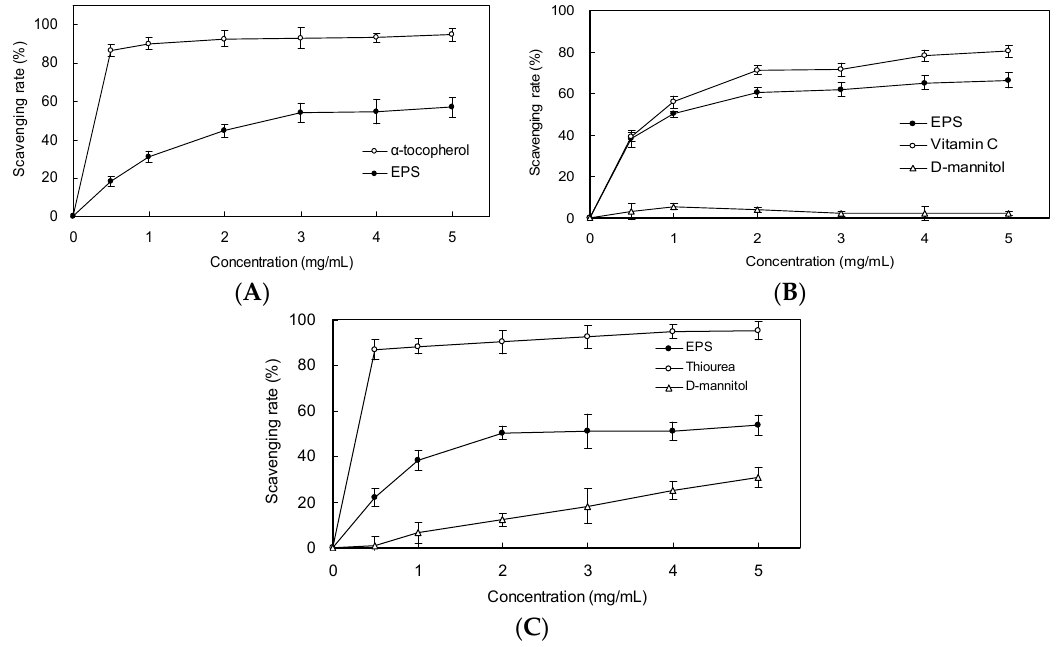
Figure 4. Scavenging effect on ( A ) DPPH radical, ( B ) superoxide anion and ( C ) hydroxyl radical by EPS from Bacillus cereus SZ1. α -tocopherol was used as positive control in DPPH radical scavenging test ( A ); vitamin C was used as positive control in the superoxide anion scavenging test ( B ); thiourea was used as positive control in hydroxyl radical scavenging test ( C ). Values represent the mean ± S.D. of triplicate samples.